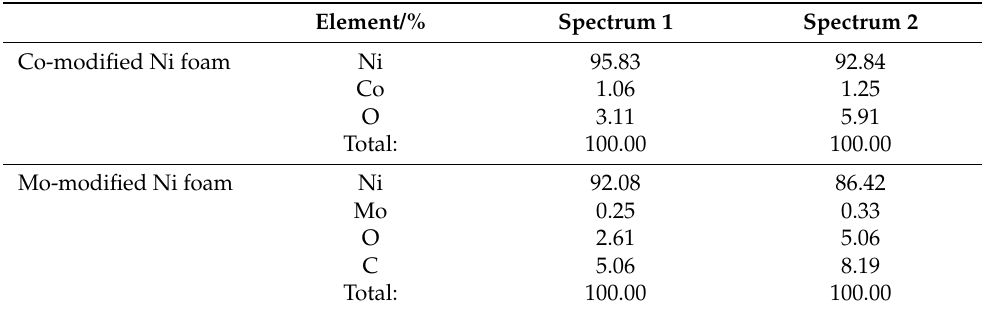
Table 1. EDX-derived (for an acceleration voltage of 15 kV) chemical composition of surface elements for freshly prepared: Co- and Mo-modified Ni foam samples.